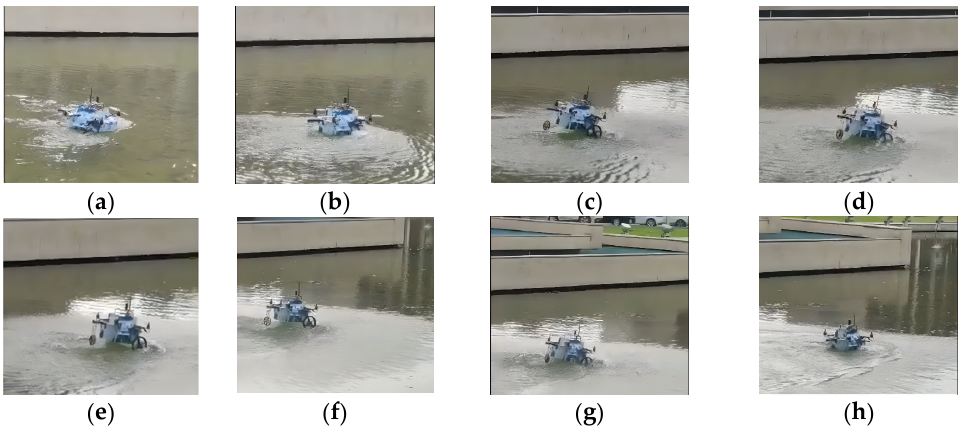
Figure 2. The robot flying on the water surface. ( a , b ) The robot controls the yaw angle. ( c – g ) The robot flying on the water surface by controlling the attitude angle. ( h ) The robot reaches the target position.